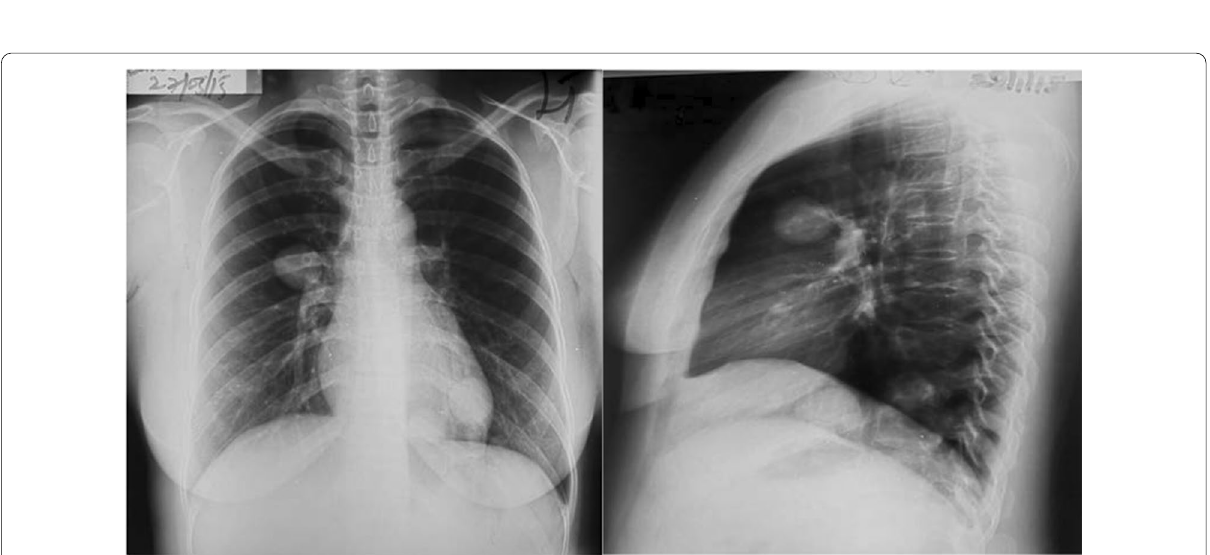
Fig. 4 Chest radiograph (posteroanterior (PA) and left lateral views) showing canon ball opacifications in both lung